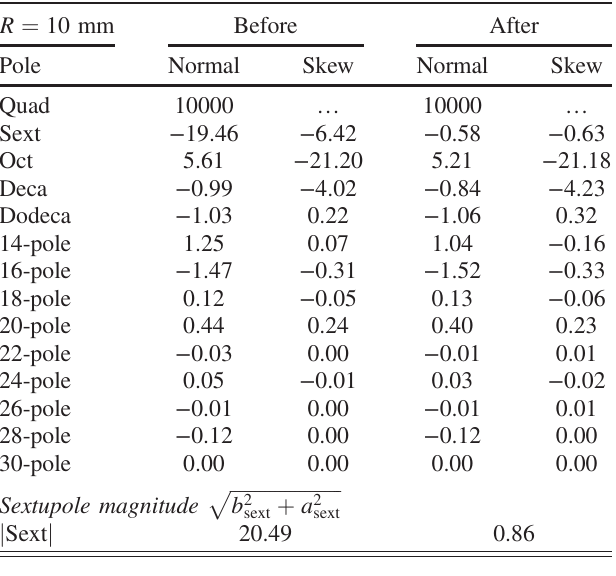
TABLE VII. Multipole harmonics during correction of a sextu- pole error in a small R&D PM quadrupole using a five-lobed rod distribution.